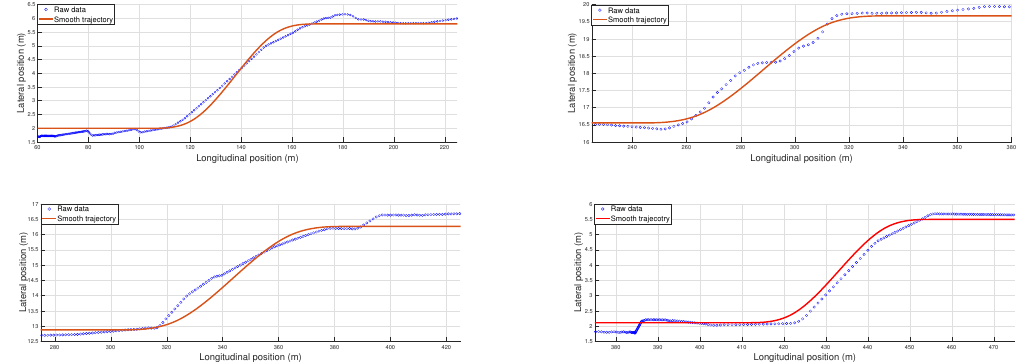
Figure 6. Comparing the raw data to the smooth